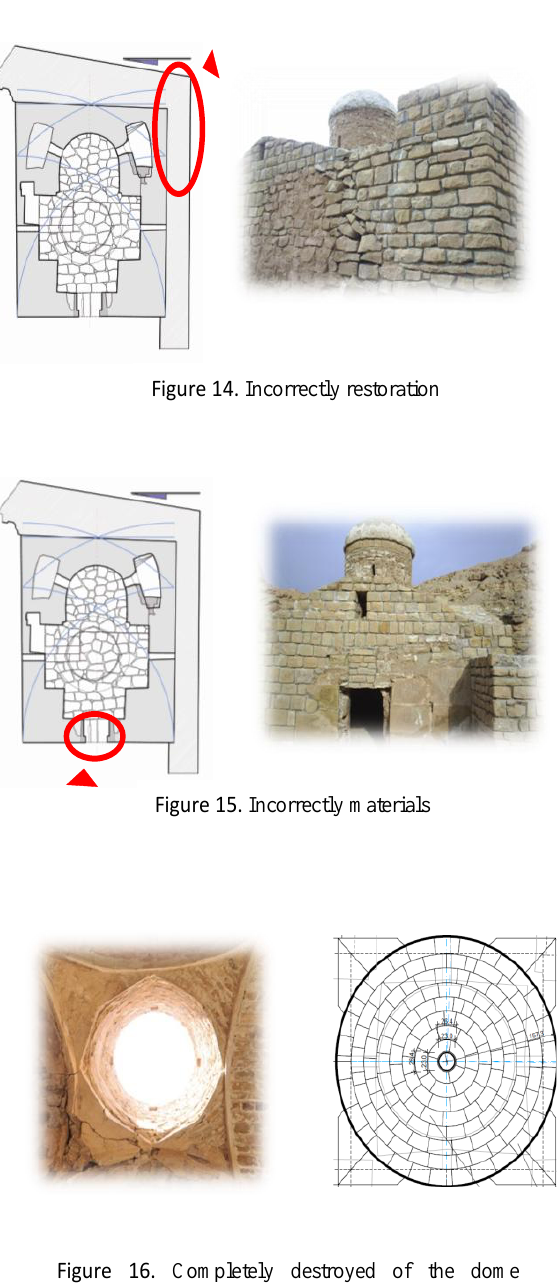
Figure 20. Incorrectly replace of